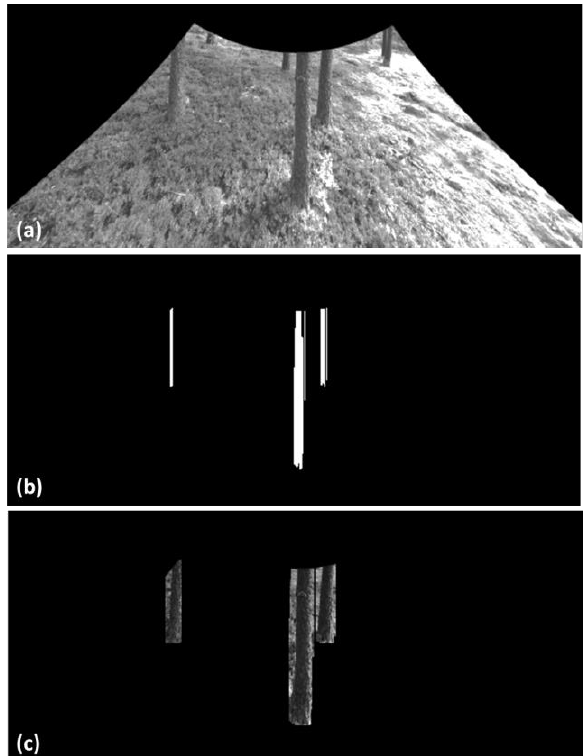
Figure 4. Example of a fisheye image collected in the terrestrial calibration field showing Aruco target corners that were automatically extracted.